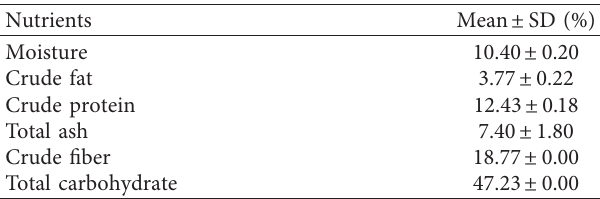
Table 1: Nutritional composition of wheat bran used for